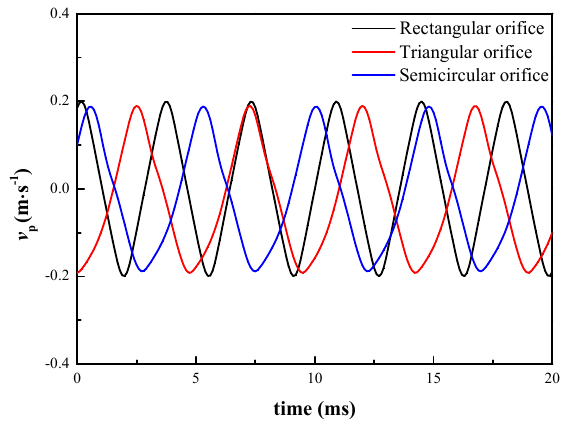
Figure 22. Velocities of different orifice shapes.